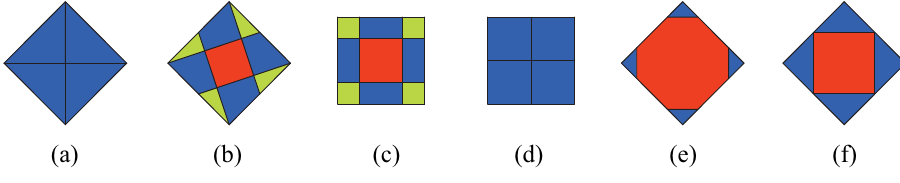
Figure 39. Ways of cutting square.